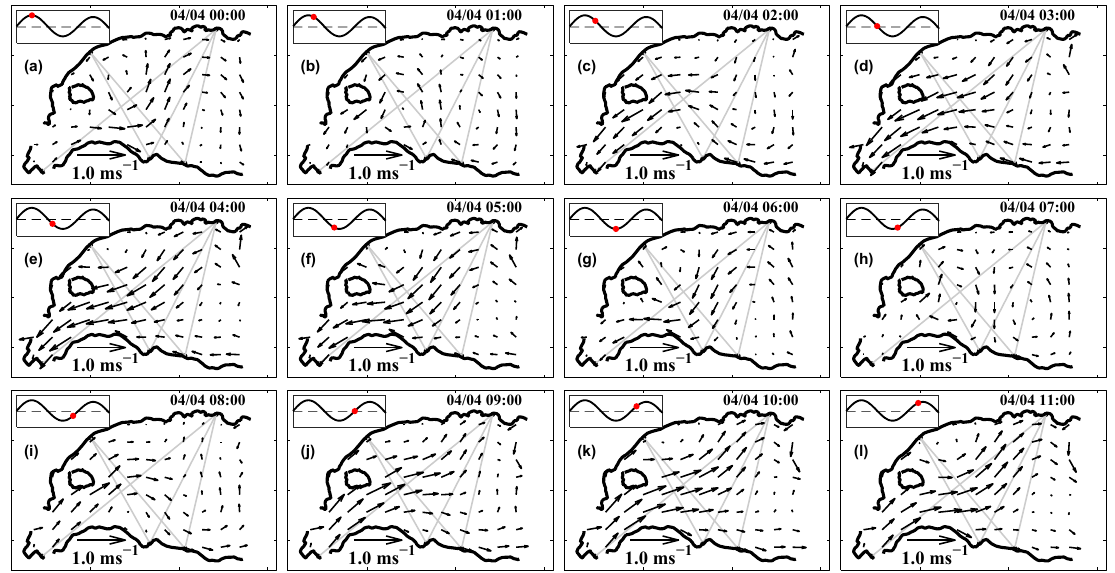
Figure 6. Hourly distributions of the inverted M 2 tidal current from 00:00 to 11:00 ( a – l ) on 4 April 2018. The corresponding sea level heights were plotted with a red dot in the sub-figures at the upper-left corner.